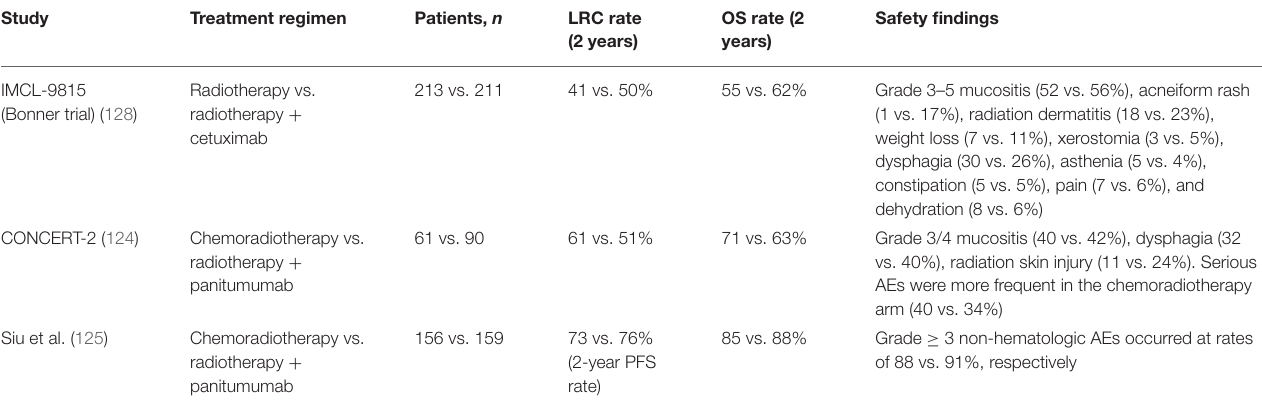
TABLE 5A | Clinical impact of cetuximab and panitumumab in LA SCCHN. Study